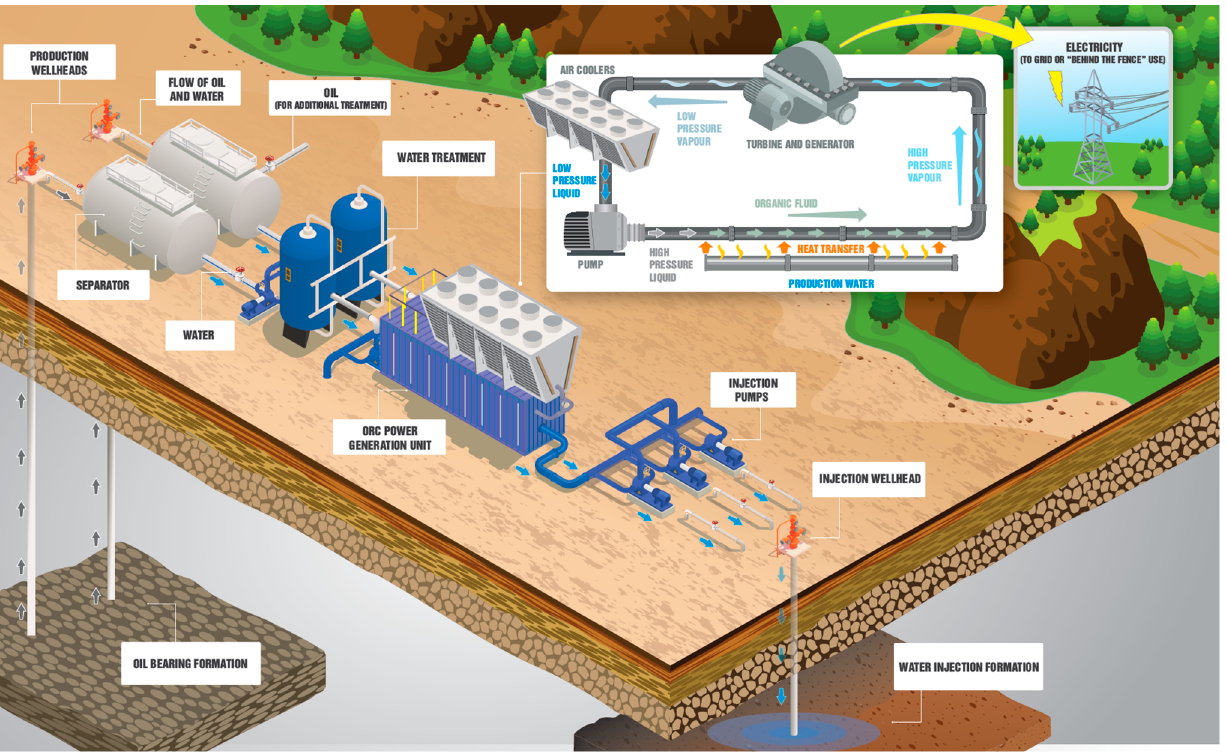
Figure 1. Schematic of an oilfield application of an ORC power generation unit. Image from Parex Resources Archives. Water flow (blue arrows), heat flux (orange arrows), phase change of the working fluid in the turbine and evaporator (light green lines), fluids produced from wells (gray arrows).